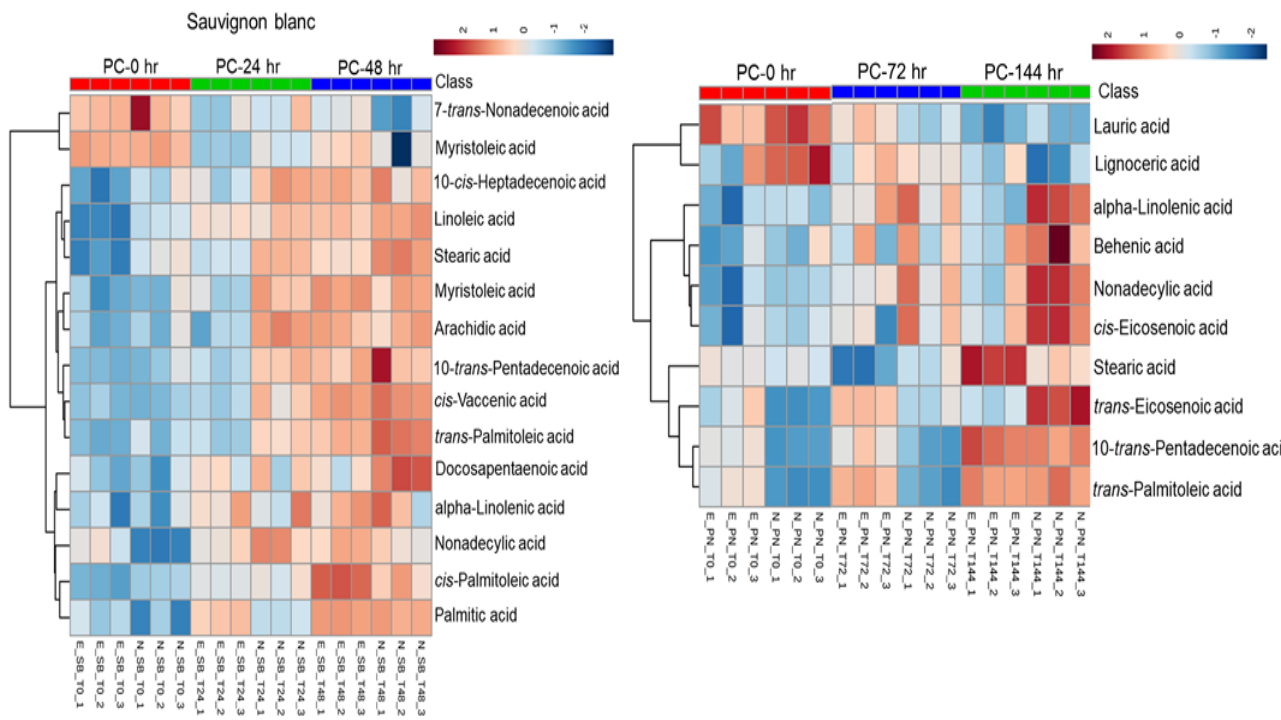
Figure 4. Heat map showing the abundance of most significant fatty acids ( p < 0.05) that were affected by pomace contact (PC) in Sauvignon blanc (SB) and Pinot noir (PN) must. Here: E = Harvest 1, N = Harvest 2, T = time of pomace contact (PC).